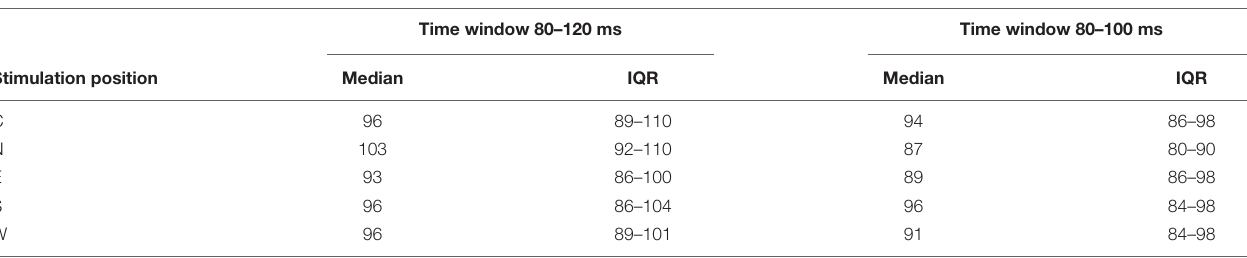
FIGURE 3 | Group grand average of N100 amplitudes at electrode C5 for (A) the main stimulation positions (Central, North, West, South, East) and (B) sub-directions with the central position as comparison (Central, North-East, North-Central, North-West, West-Central, South-West, South-Central, South-East, East-Central). The TMS artifact (gray bar) has been cut out. TABLE 1 | Descriptive statistics of N100 latencies at electrode